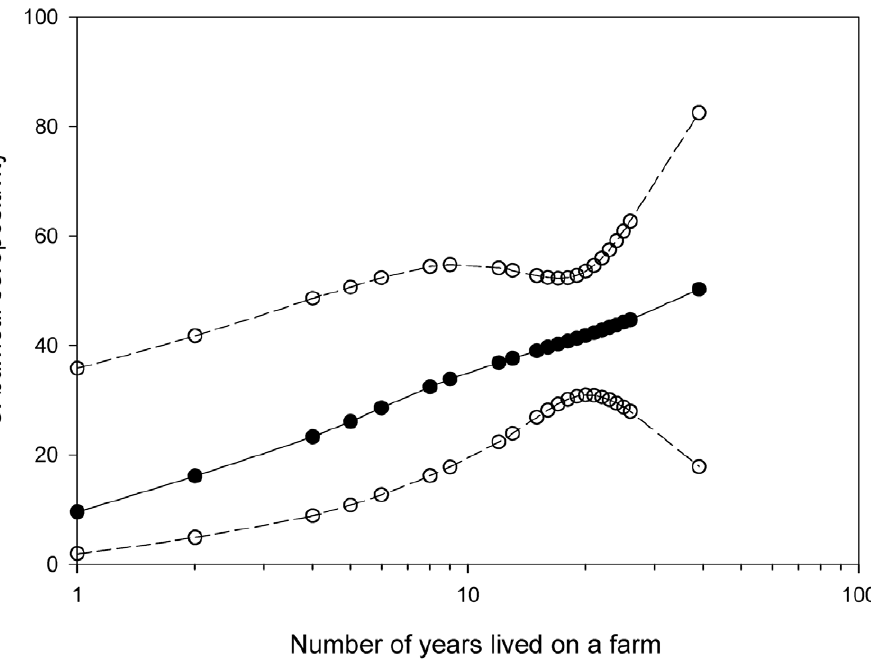
Figure 2. Association between C.burnetii seropositivity and number of years lived on a farm (p=0.028, spline 2 d.f p=0.586) for students who ever lived on a farm (n=100). Open circles represent the 95% upper and lower confidence limits.